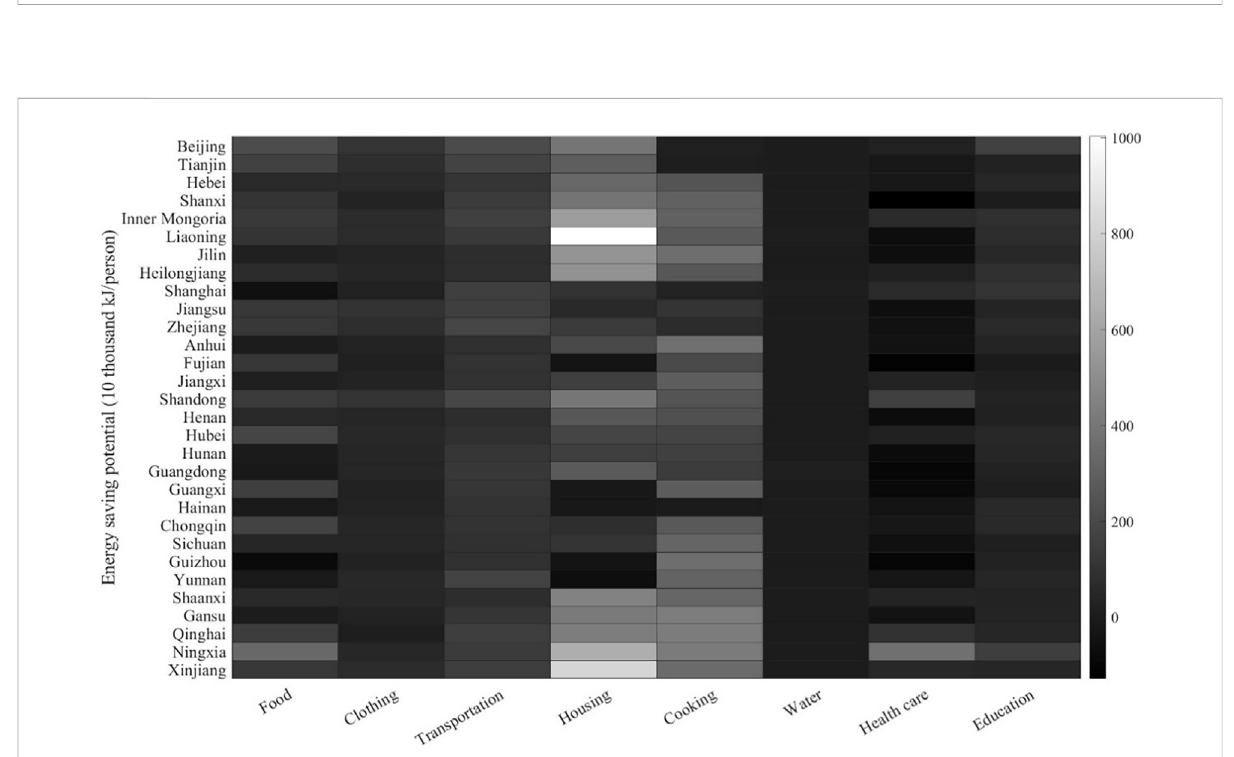
FIGURE 7 Energy saving potential of different consumption categories in different